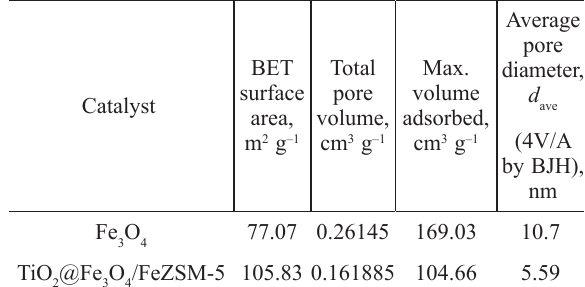
Table 1 – Nitrogen adsorption results of prepared catalysts